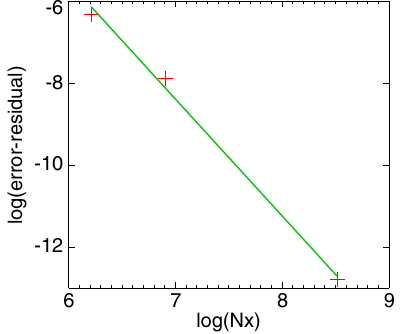
FIG. 12. Results from V ORPAL simulations, in which a laser pulse with the standard paraxial form is launched from one surface of the simulation domain, and then compared with the analytic form after it has propagated onto the mesh. In order to see numerical convergence with resolution, it is required that one subtract from the error a residual constant that depends upon details of the laser pulse length and shape. In this example, the convergence is faster than quadratic, which cannot be expected in general.